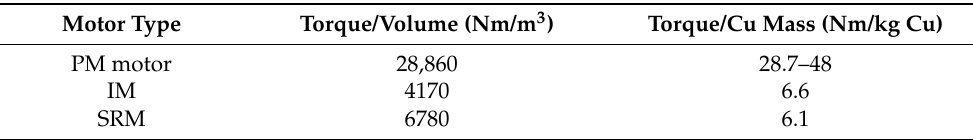
Table 16. Typical torque density values of some motors. Data from [30].